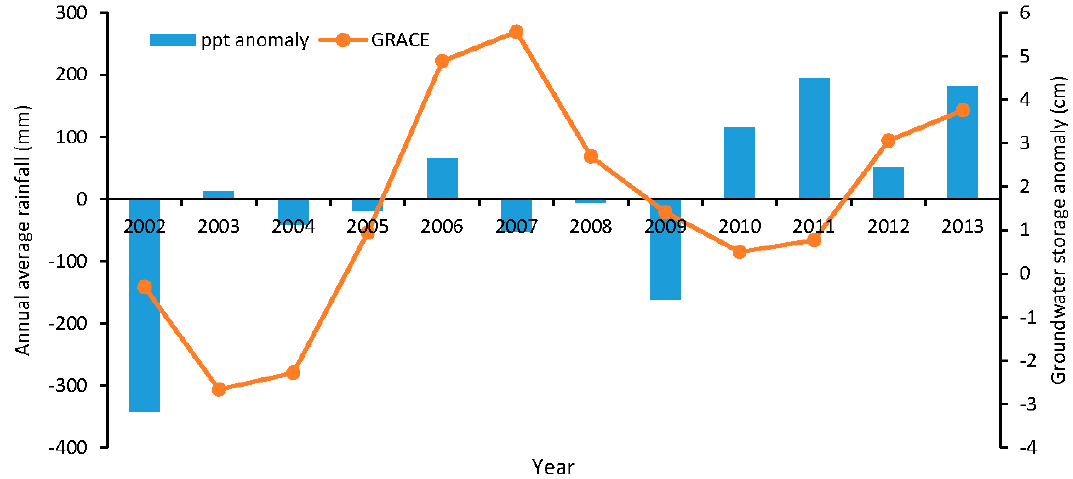
Figure 8. Comparison of precipitation anomaly (anomaly calculated using average of 2002–2013) and GRACE net estimated groundwater